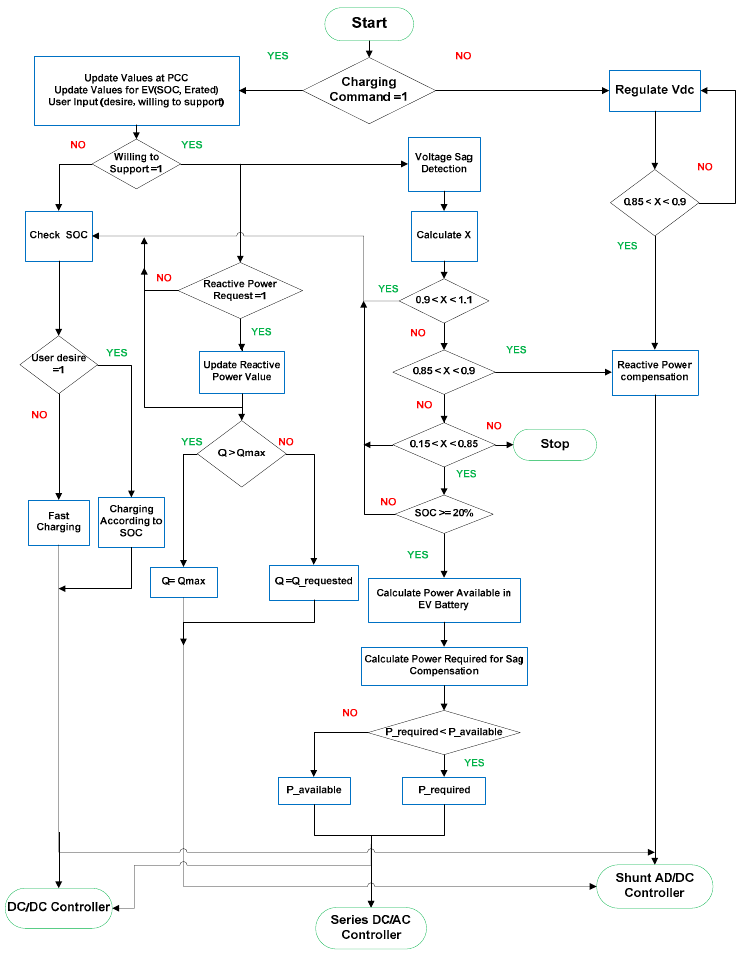
Figure 8. Complete system control algorithm flowchart.